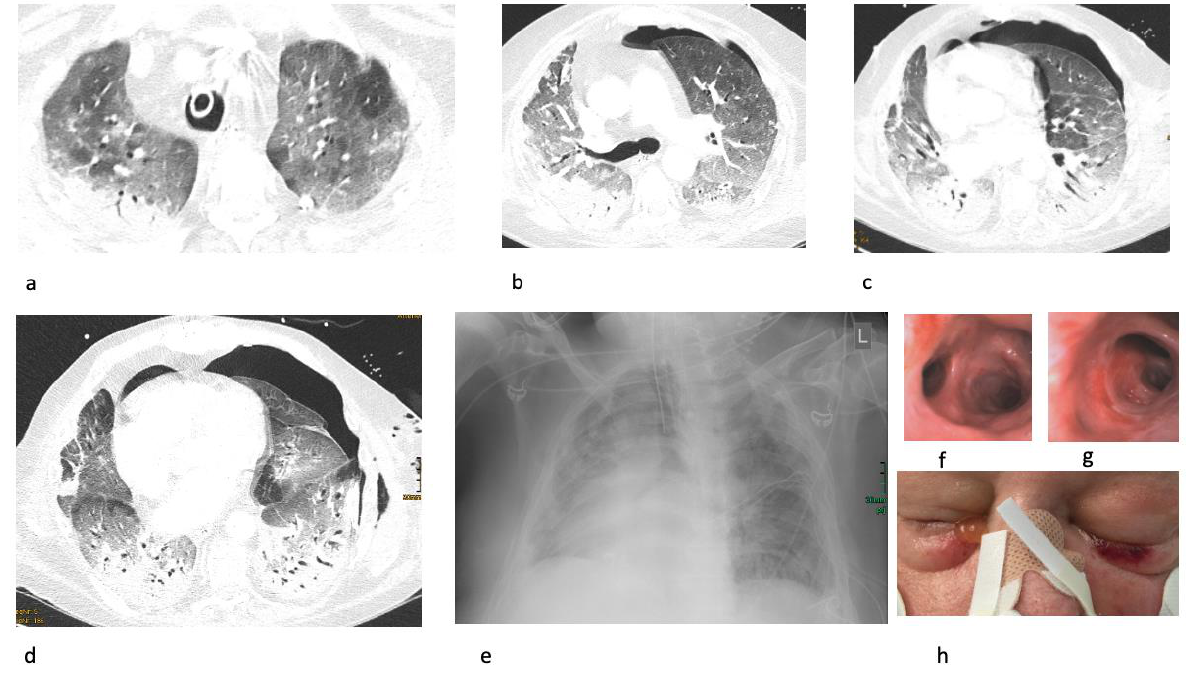
Figure 1. CT scan, chest X-ray, bronchoscopy images, and subcutaneous emphysema. CT scan showing ARDS, GGO and pneumothorax ( a – d ); chest X-ray after pneumothorax drainage ( e ); bronchoscopy without endobroncial mucus retention ( f,g ); massive subcutaneous emphysema ( h ).